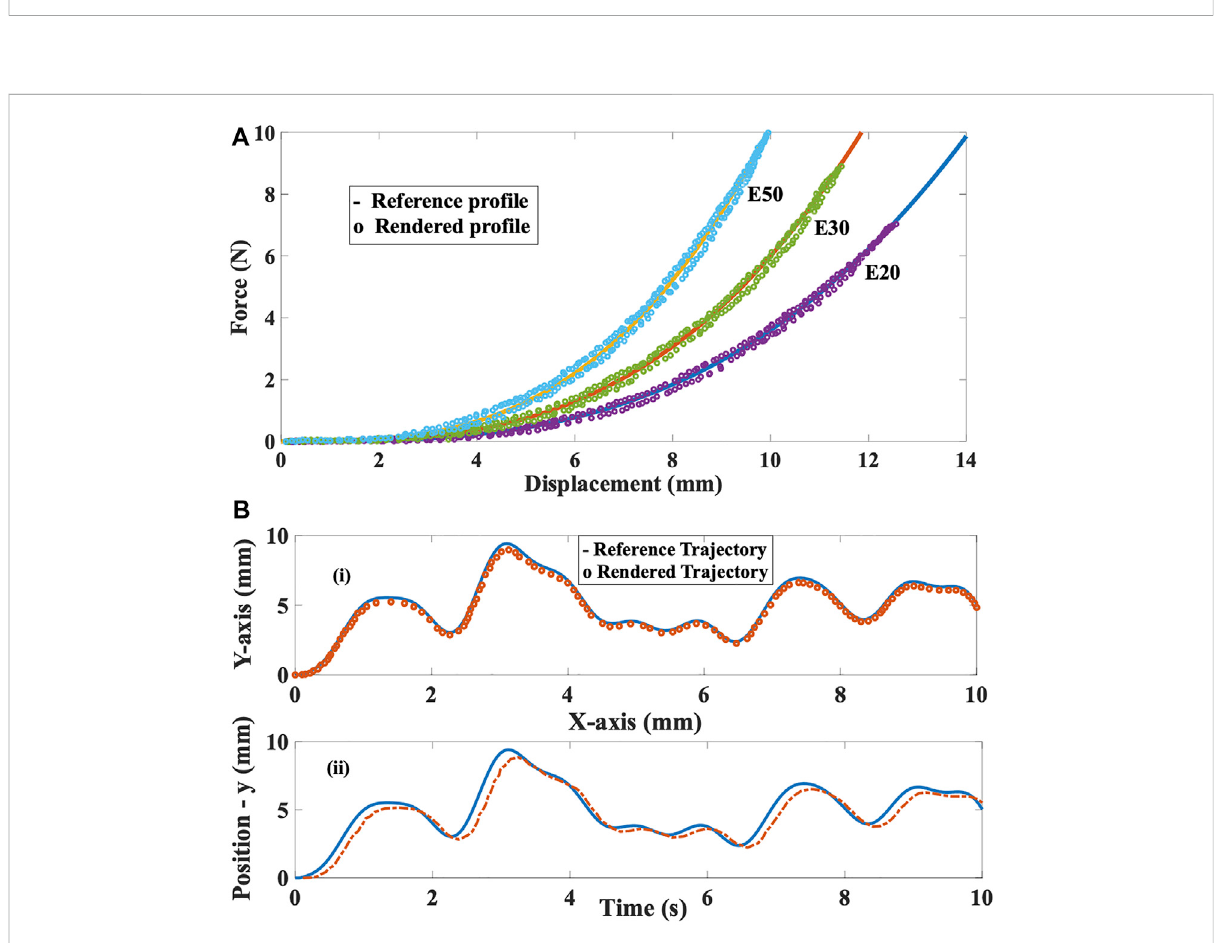
FIGURE 8 (A) Nonlinear stiffness tracking for E20, E30 and E50 (B) Shape pro fi le comparison and position tracking in time domain along